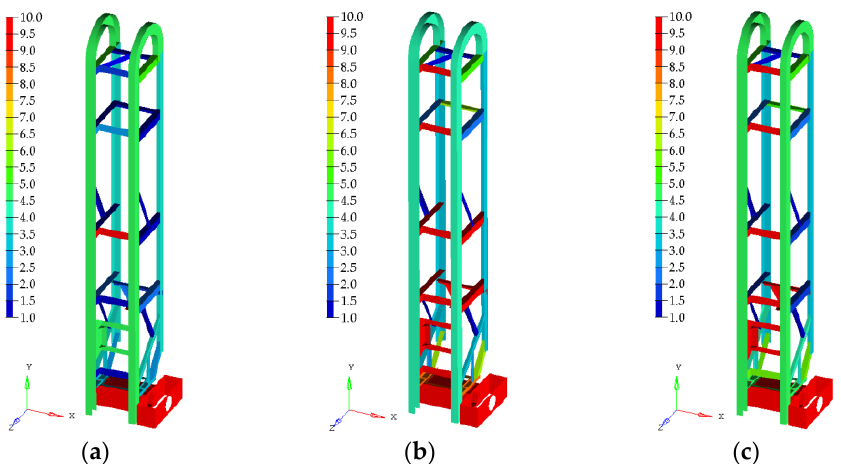
Figure 13. Optimization results: ( a ) optimization scheme A; ( b ) optimization scheme B; ( c ) optimization scheme C.